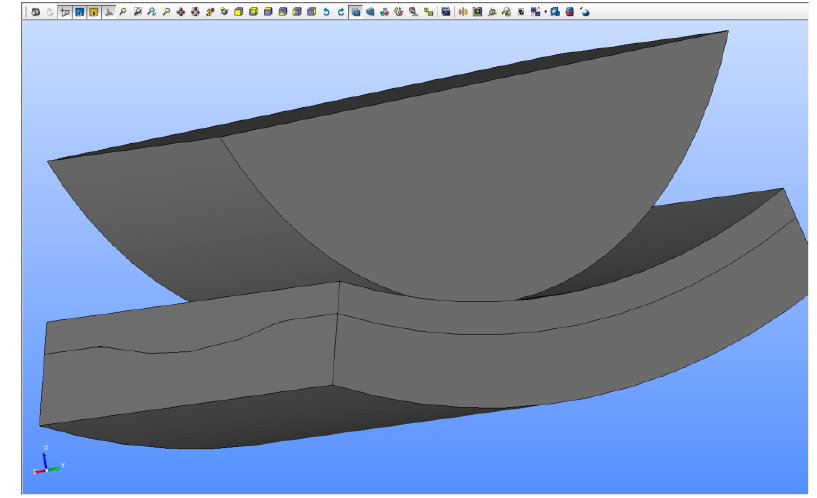
Figure 8. System CAD model—side surface of regenerator batch worn to depth of 5 mm.